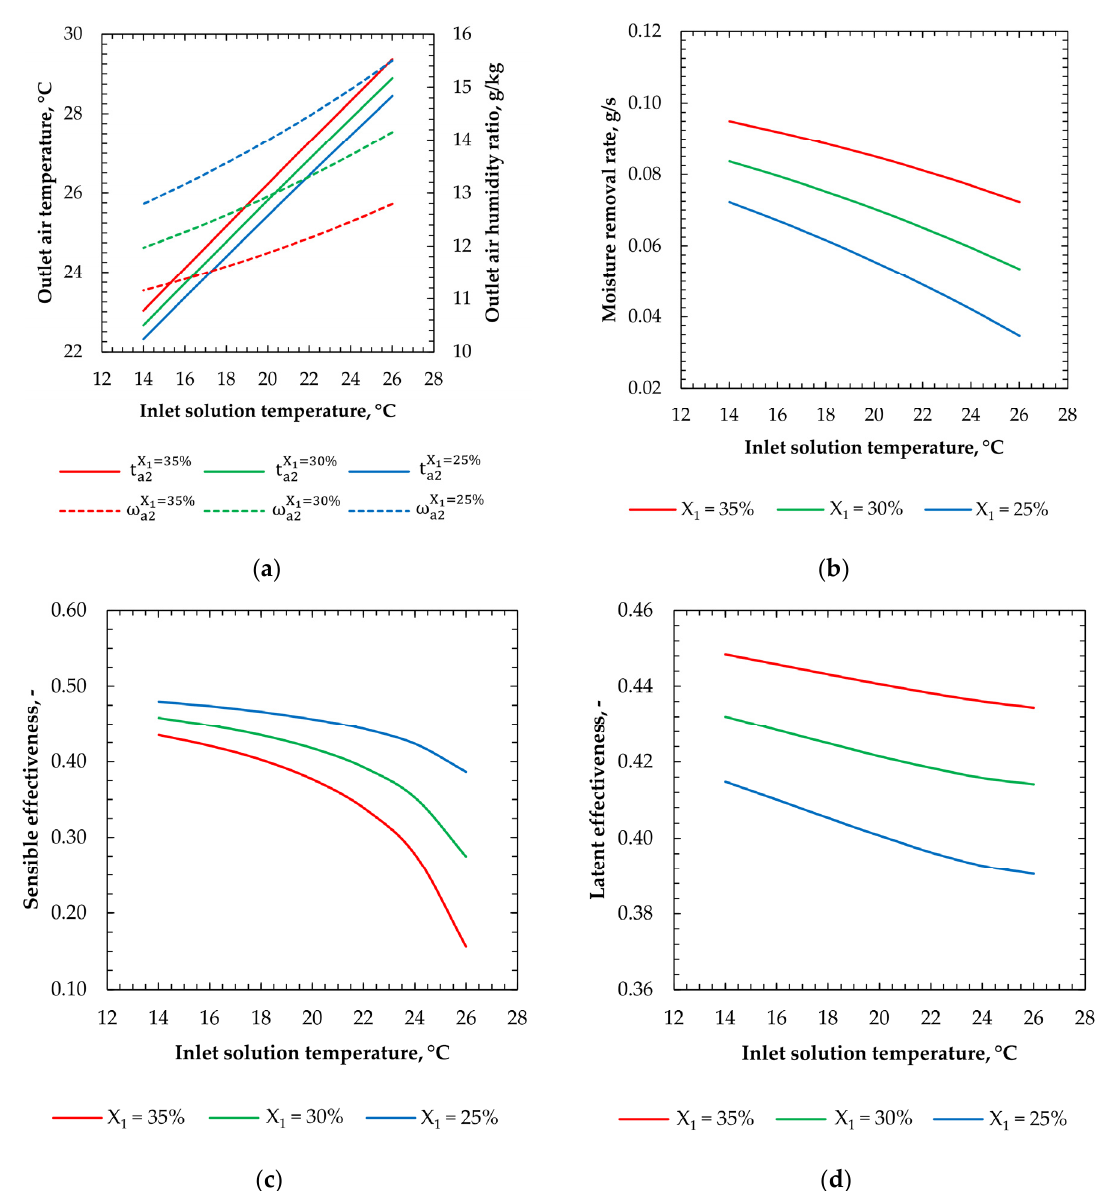
Figure 8. Effect of inlet solution temperature in regard to different solution concentrations: ( a ) on outlet air temperature and outlet air-humidity ratio; ( b ) on moisture removal rate; ( c ) on sensible effectiveness; ( d ) on latent effectiveness.